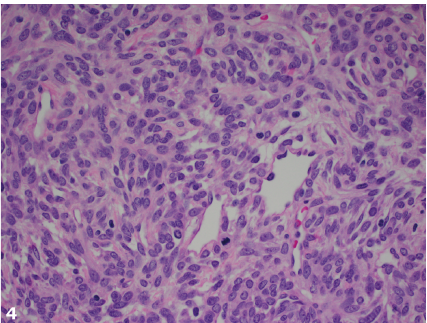
Figure 4: The tumor cells are ovoid to spindled with scant cytoplasm, indistinct borders, and vesicular nuclear chromatin. A mitotic figure is present in the lower-half of the field (H&E, original magnification × 400).